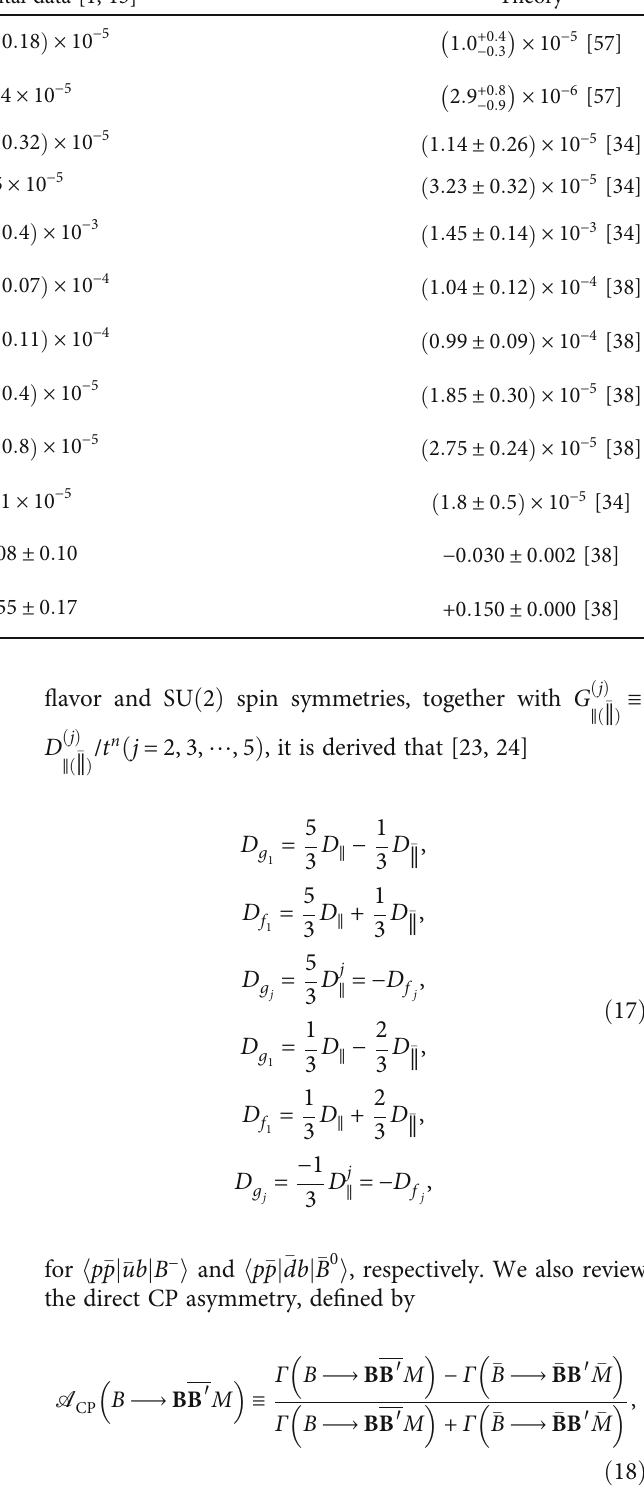
Table 3: Theoretical results of the two- and three-body B decays with the baryon (meson) containing a charm quark, which are compared with the experimental data. Decay mode Experimental data [1, 13]